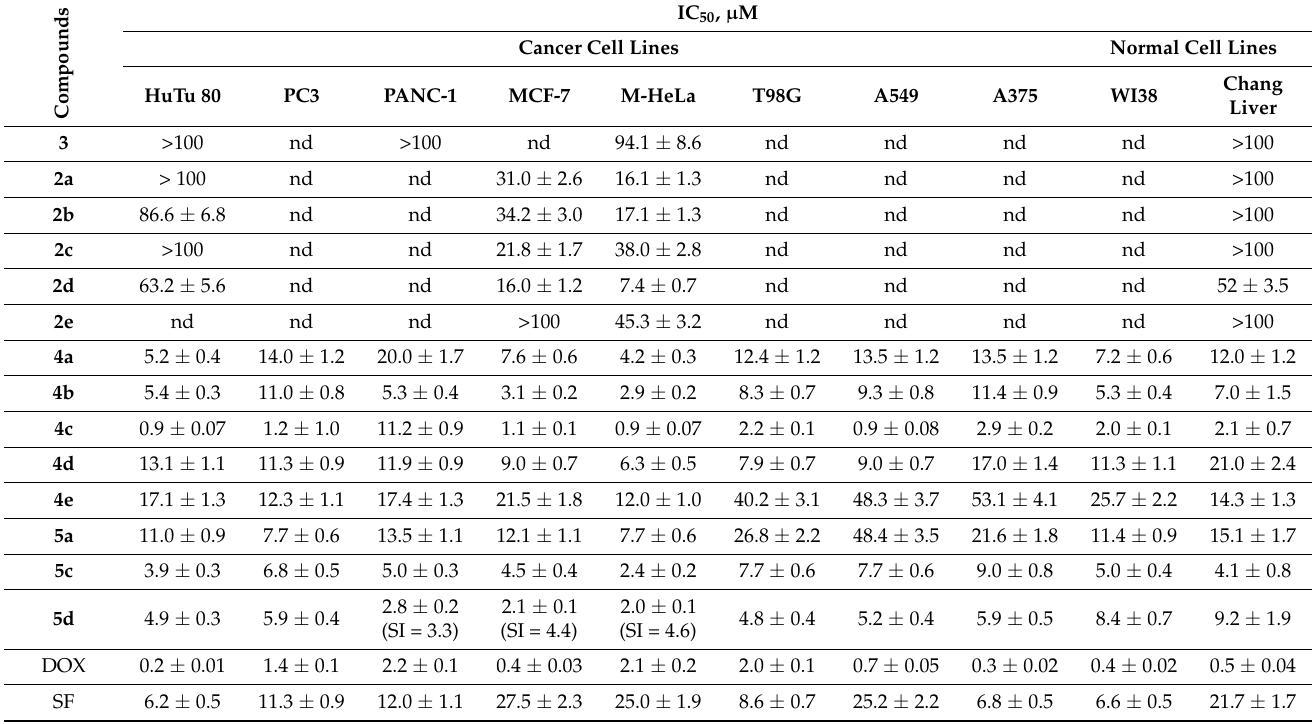
Table 1. In vitro cytotoxic effects for the tested SHP-benzofuroxan